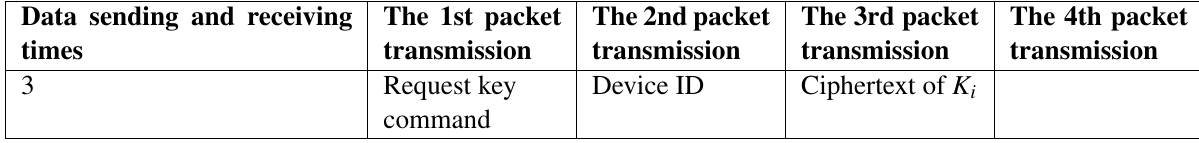
Table 1 Communication overhead of key distribution